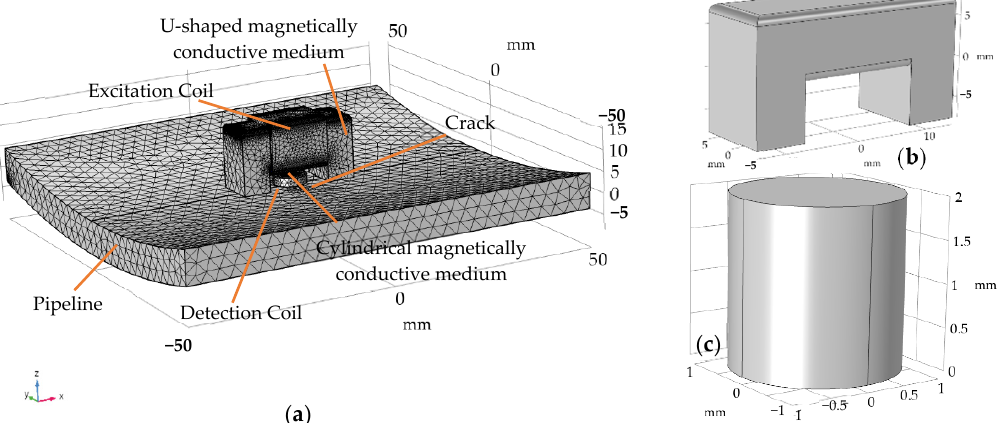
Figure 4. ( a ) Models with magnetically conductive medium; ( b ) dimensions of the magnetically conductive medium of the excitation coil; ( c ) dimensions of the magnetic conductive medium of the detection coil.